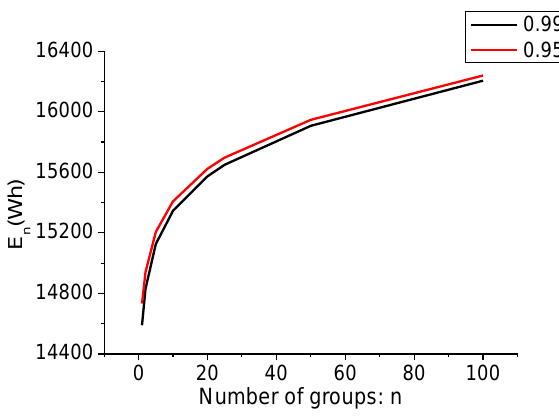
Figure 5. E n under given capacity distribution.